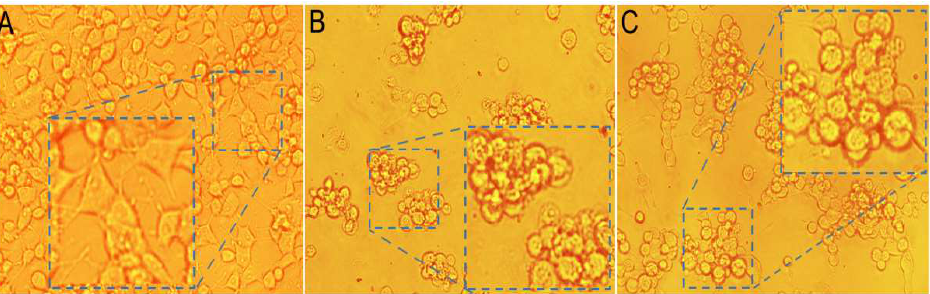
Figure 8. Photomicrographs of cells after incubated by 20 μM ZSW for ( B ), 20 μM ZSW + 20 μM ascorbic acid for ( C ) and blank group for ( A ).(inset: partial enlarged detail.). (1 μM refers to 10 –6 mol · L –1 )